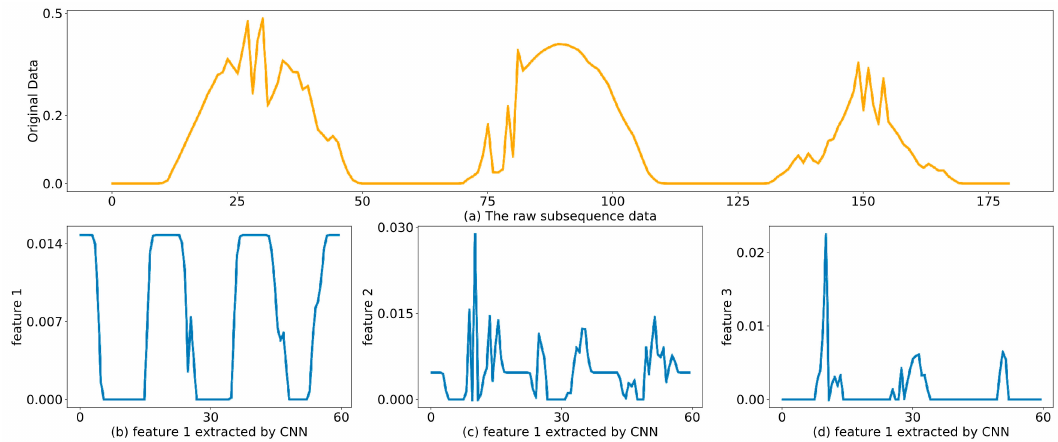
Figure 15. The visualization of feature maps extracted by CNN from the raw subsequence data. ( a ) the original data before convolution operation; ( b ) The first feature map yielded by convolution operation; ( c ) the second feature map yielded by convolution operation; and ( d ) the third feature map yielded by convolution